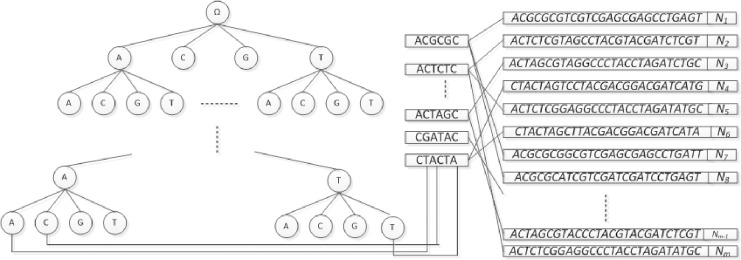
PCR sequence alignment model.